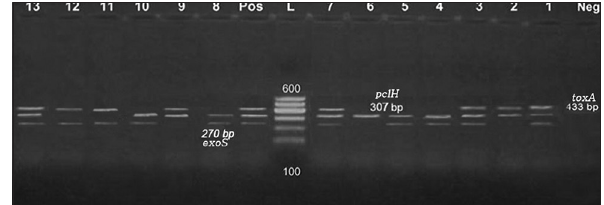
Figure-2: Multiplex polymerase chain reaction detection of virulence genes in Pseudomonas aeruginosa isolates showing: L: 100 bp DNA ladder. Lanes 1-13: P. aeruginosa isolates. Lane Pos.: Positive control; amplification of 270 bp represented exo S, 307 bp represented plc H, and 433 bp represented tox A. Lane Neg.: Negative